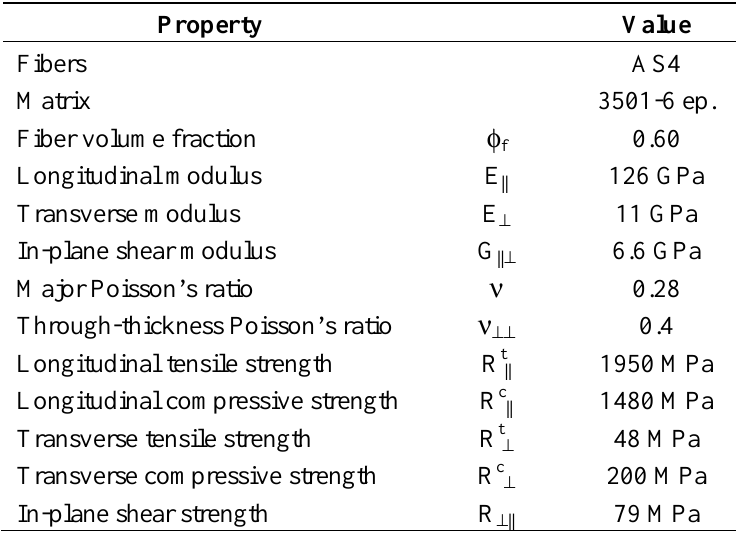
Table 3. Material properties of the prepreg laminate system [20].